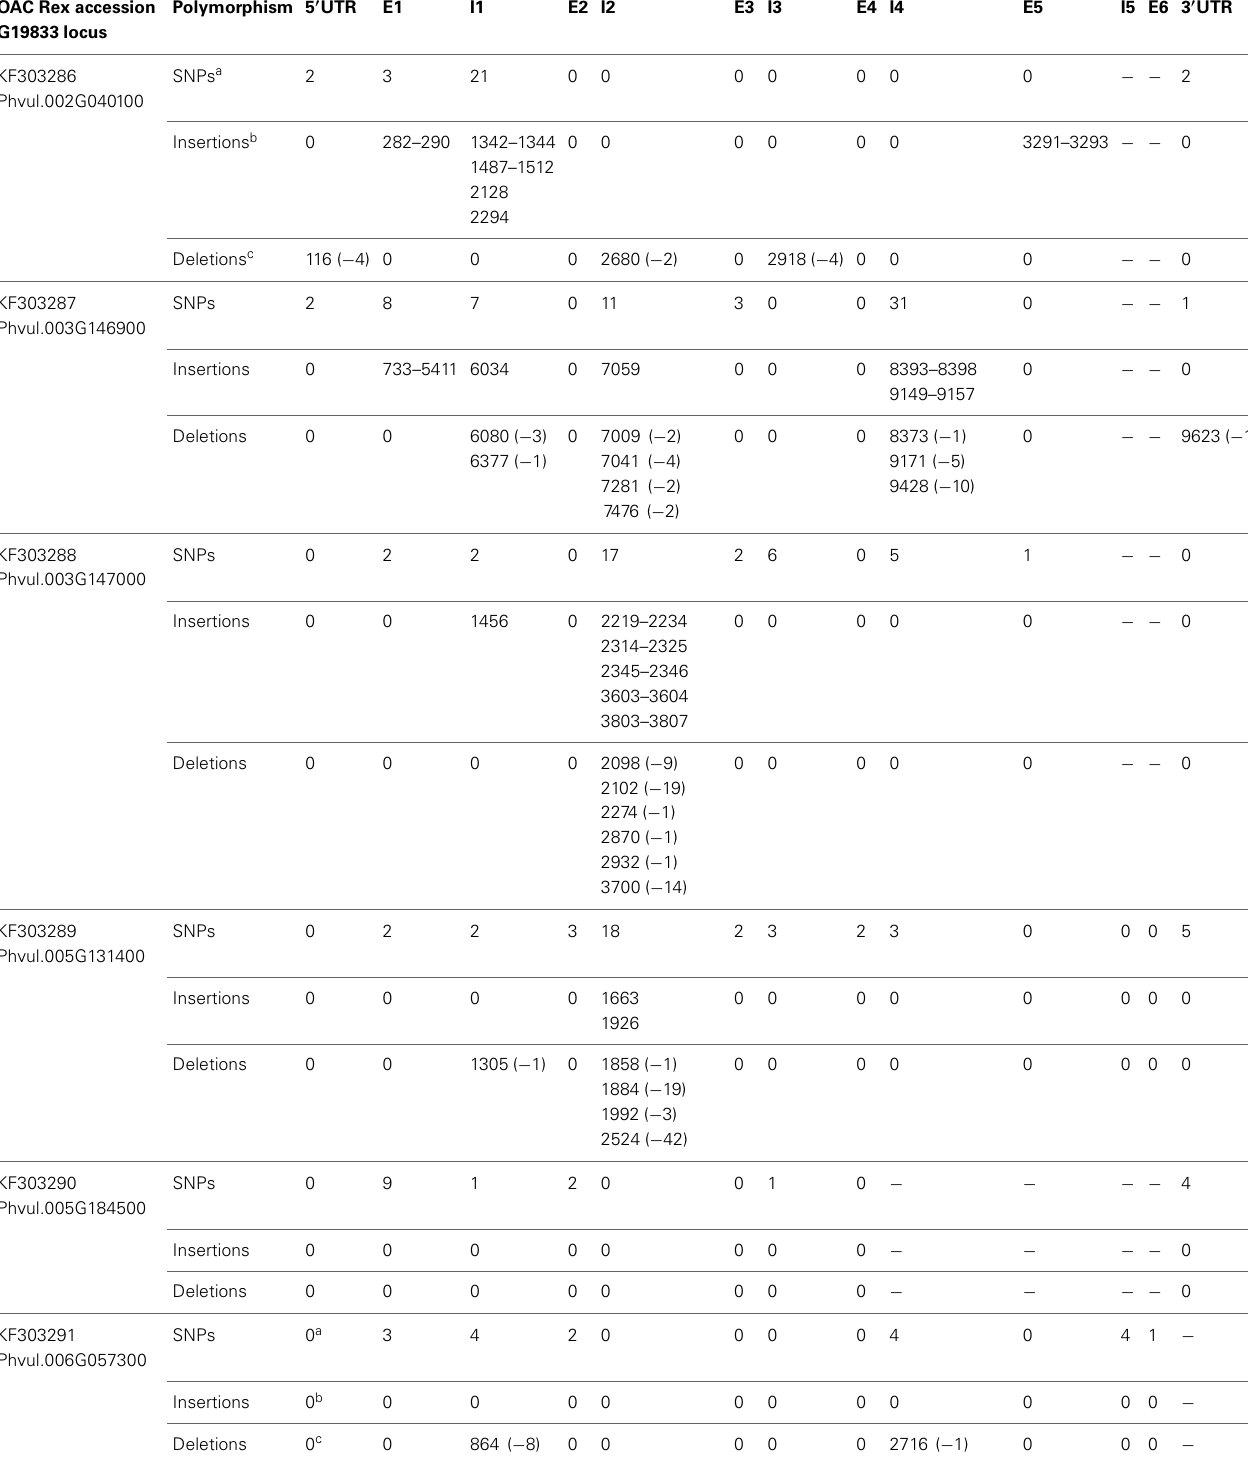
Table 8 | Polymorphism of 4CL gene sequences in Mesoamerican common bean cultivar OAC Rex compared to the reference, Andean landrace